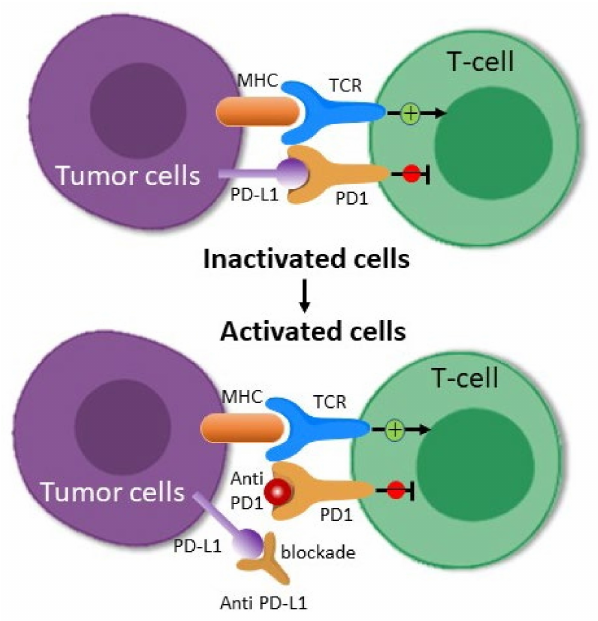
Figure 2. Anticancer mechanism of PD-1/PD-L1 inhibitors. Tumor cells escape from the anti-tumor activity of T cells by the binding of PD-L1 to the PD-1 receptor. PD-1 or PD-L1 antibodies block the binding of PD-L1 on tumor cells to PD-1 receptors on T cells, which allows T cells to target tumors.